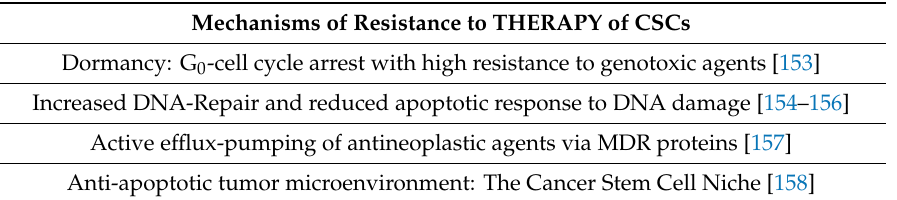
Table 2. Major mechanisms of resistance of CSCs to